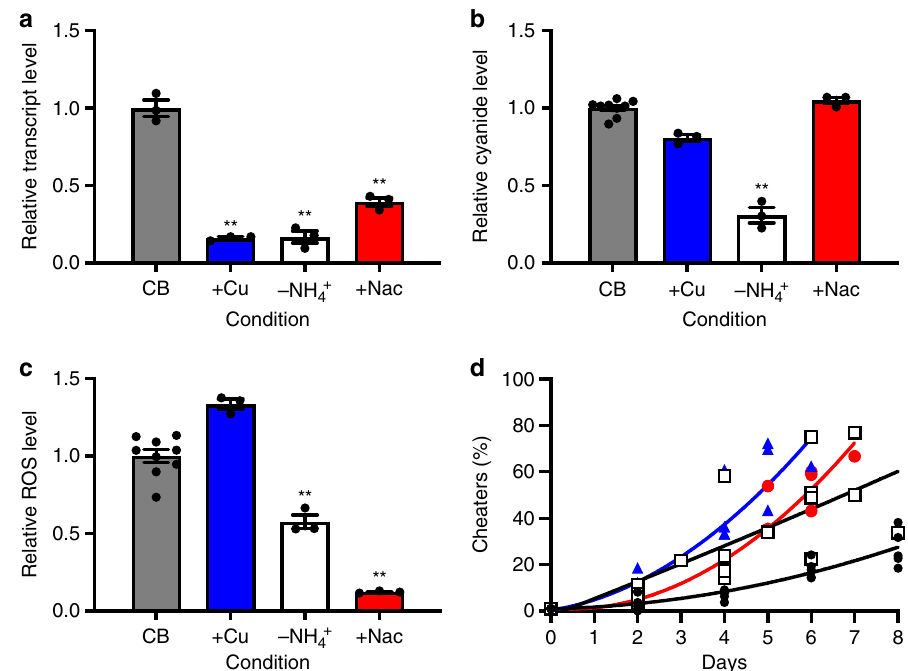
Fig. 4 Inhibition of cioA expression as a potential strategy to destabilize populations of P. aeruginosa . Expression of a cioA and b production of cyanide when WT PAO1 is grown in casein broth (CB, black) with the addition of 1 mM copper sulfate ( + Cu, blue). Shown in comparison are casein broth without ammonium sulfate ( − NH 4 + , white), and media with added N -acetylcysteine ( + Nac, red). c ROS levels in the same conditions. d Cheater frequency when WT cooperators and LasR mutants are grown in these conditions. In all co-cultures, the starting ratio of WT:LasR mutants was 99:1. At least three biological replicates were performed. Lines represent best- fi t polynomial regressions for each condition. For a – c , means, s.e.m., and individual biological replicates are shown. Statistical signi fi cance determined by paired Student ’ s t -test versus CB alone; ** p < 0.01. UD;